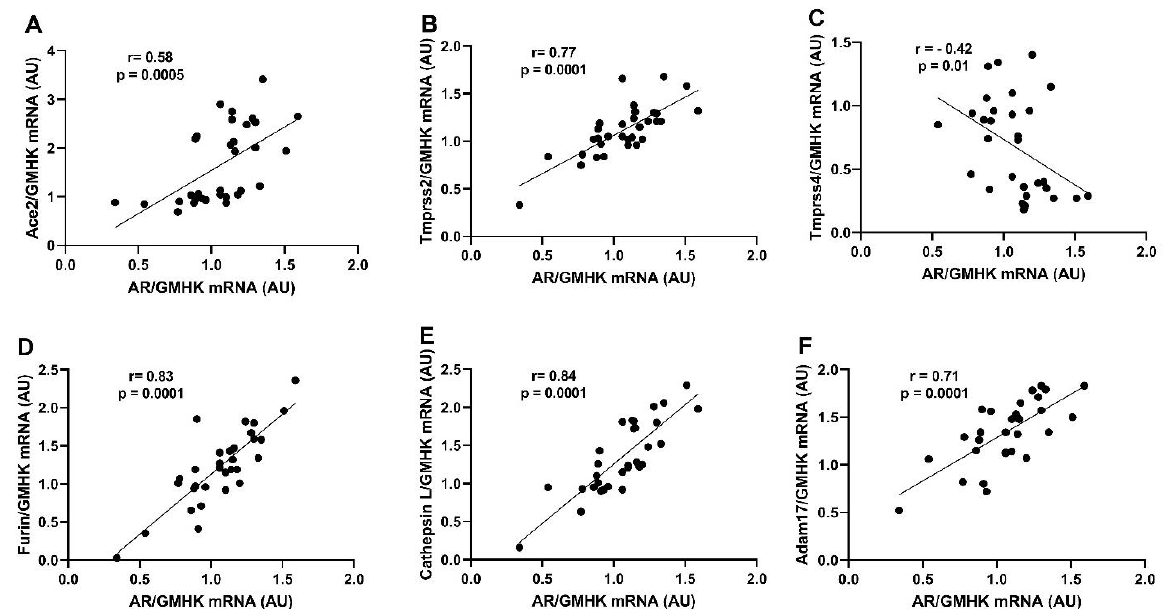
Figure 6. Correlations between renal androgen receptor mRNA expression and SARS-CoV-2 viral entry proteins. Animals were treated with dihydrotestosterone (DHT) or vehicle (Veh) and maintained in low (LFD) or high (HFD) fat diet for 90 days. Androgen receptor and SARS-CoV-2 viral entry proteins renal mRNA expression was quantified by RT-qPCR. Pearson’s correlation coefficients (r) were calculated between androgen receptor and Ace2 ( A ), Tmprss2 ( B ), Tmprss4 ( C ), furin ( D ), cathepsin L ( E ), and ADAM17 ( F ) mRNA expression.